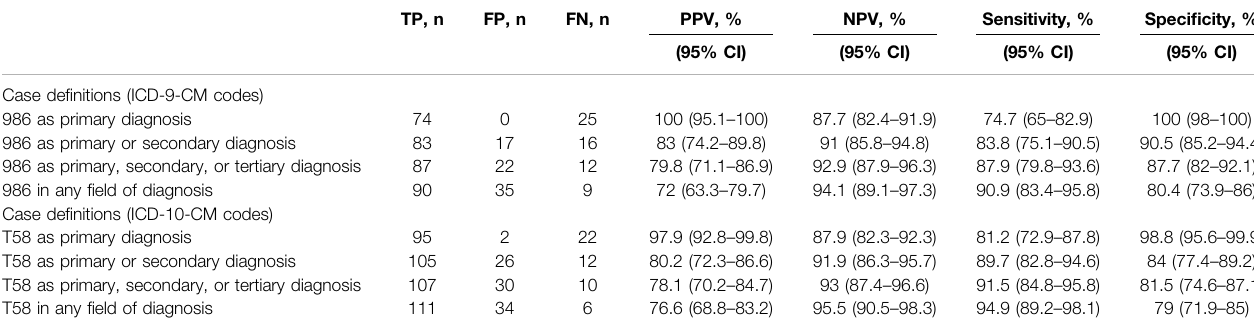
TABLE 1 | Accuracy of different case de fi nitions to identify carbon monoxide poisoning cases.